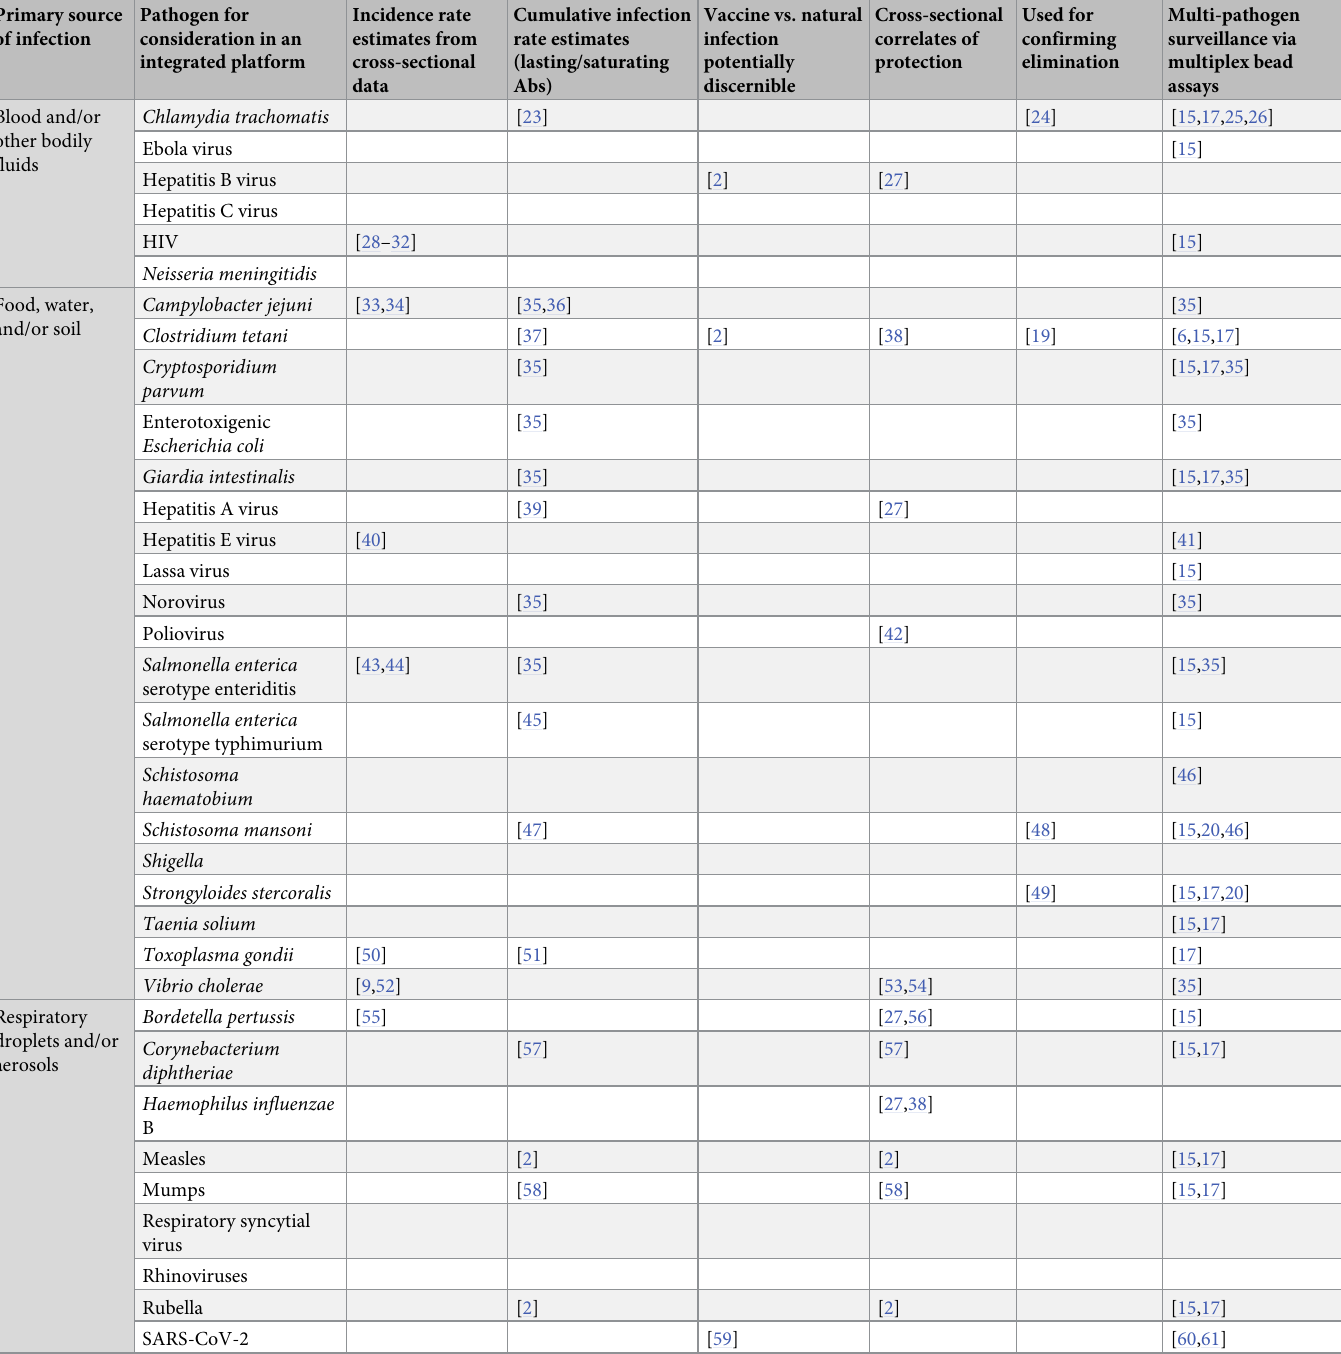
Table 1. Published studies for different use-cases of sero-epidemiology by pathogen and source of infection. Pathogens that could be considered for an integrated platform are listed and grouped by primary source of infections. Ways in which sero-epidemiology has previously been used in surveillance of each pathogen are indicated and accompanied by published examples, including both reviews and primary research articles. The numbers in the table indicate references and the gaps illustrate research or surveillance use-cases where serology has not been